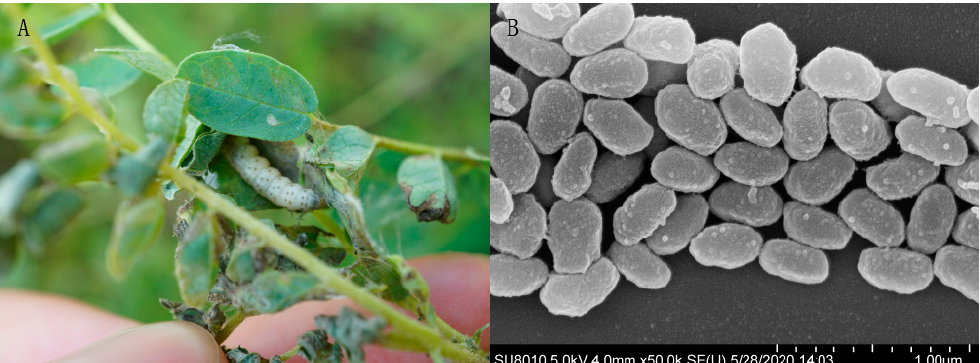
Figure 1. Host larva displaying symptoms of MaphGV infection and the corresponding occlusion bodies. ( A ) Matsumuraeses phaseoli larva in the glued Astragalus membranaceus leaves exhibiting symptoms for baculovirus infection. ( B ) MaphGV occlusion bodies as seen under scanning electron micrograph. The scale of measurement is marked in the bottom right corner.